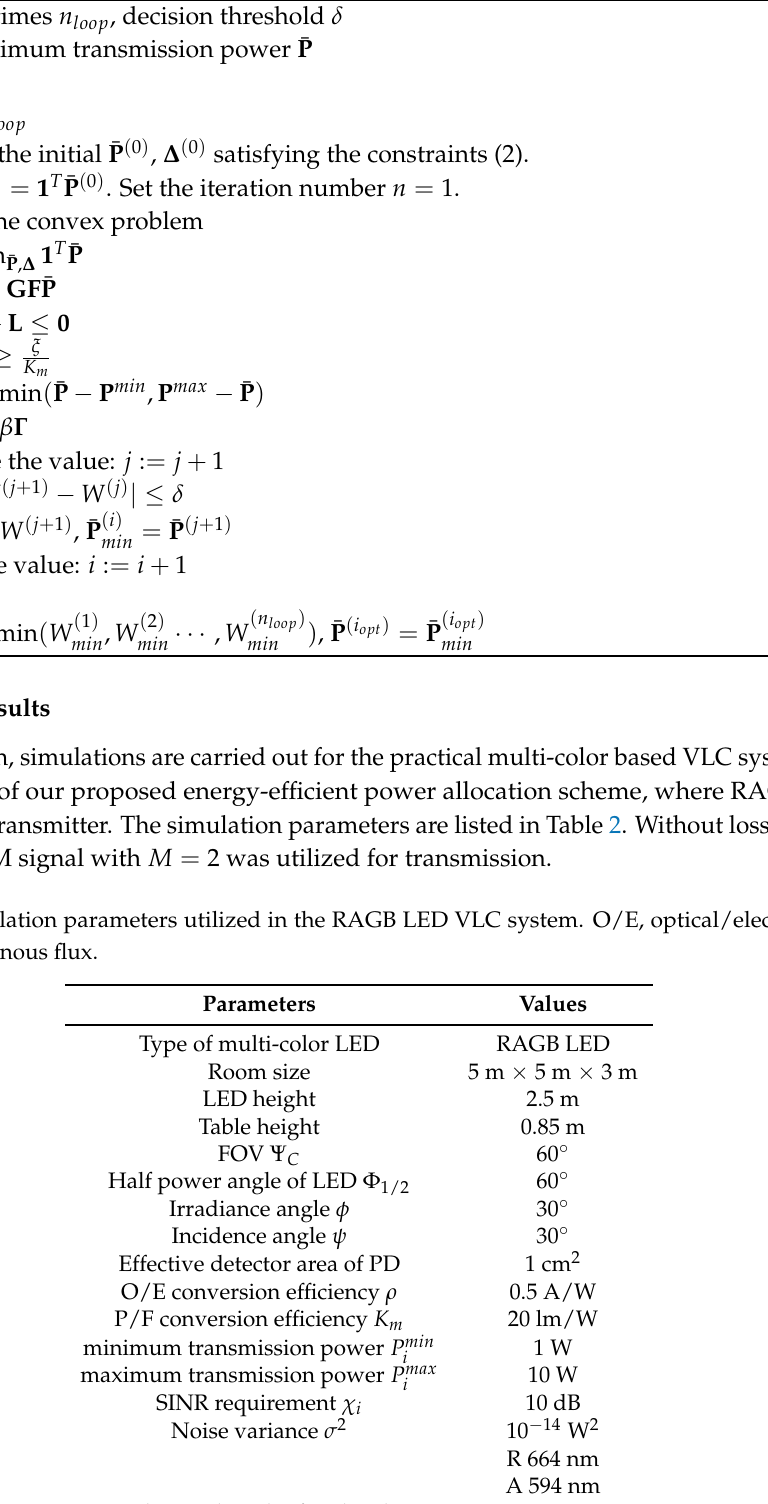
Algorithm 1: Energy-efficient optimization design.